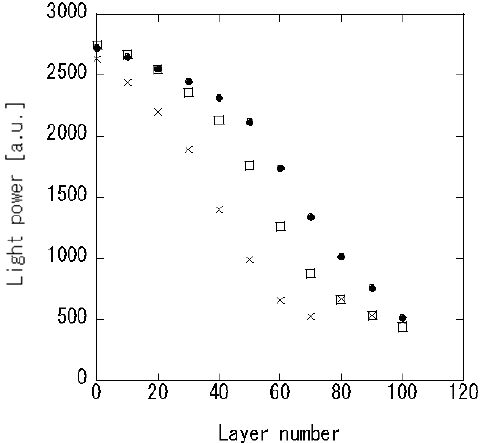
Figure 2. Propagating light intensity of the 60-layers deposited sensor in air (- ● -), water (- □ -) and ethanol (-×-).